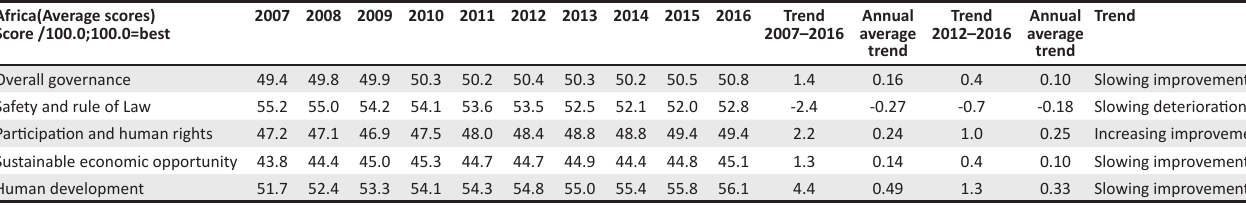
TABLE 1: Contrasting governance performance at category level. Africa(Average scores) Score